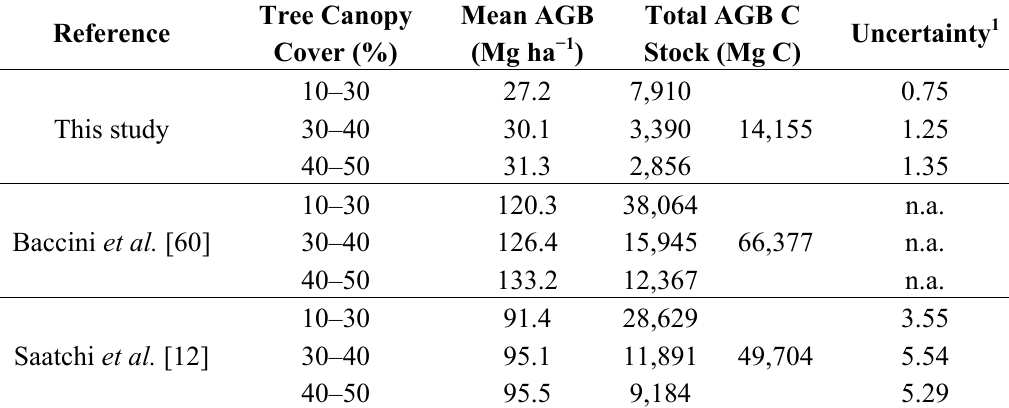
Table 4. Mean AGB, Total AGB, AGB C stock and uncertainty per tree canopy cover class in the study area with tree canopy cover between 10% and 50% (1,157 ha), derived from this study (BagSGB model), Baccini et al. [60] and Saatchi et al. [12] ( 1 the uncertainty refers to the coefficient of variation (%) (this study) and error (%) [12]; n.a., not